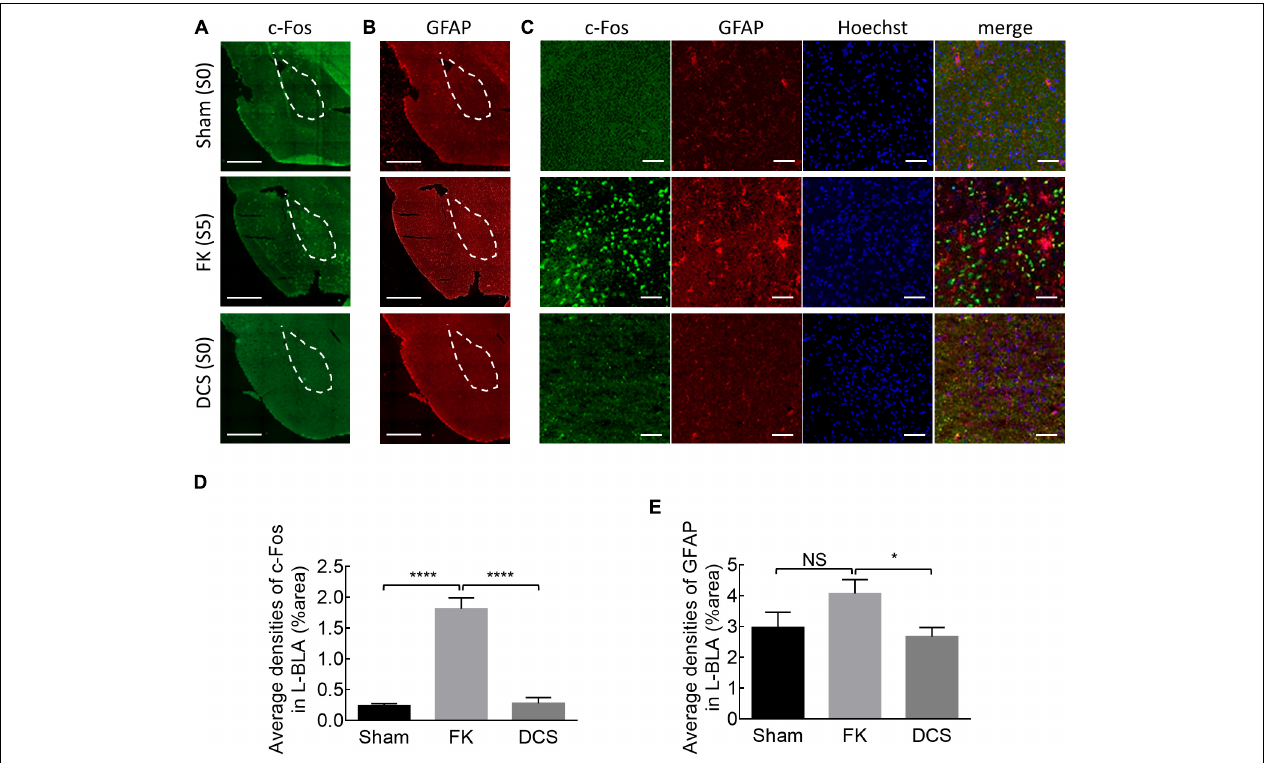
FIGURE 6 | Marked anticonvulsant effect of DCS demonstrated histologically in fully kindled rats. (A) Representative immunostaining images show that cFos expression is markedly increased after the rat was fully kindled (FK, middle panel) when compared to the control rat which acts as normal without kindling (sham, upper panel). The cFos expression was attenuated or even is essentially absent in the left basolateral amygdala (L-BLA) (dotted area) after 40 sessions of 100 µ A, 10 s DCS applied immediately before the challenge stimuli (DCS → Ch) in a fully kindled rat (DCS, lower panel) if compared to the fully kindled rat without DCS (FK). Behaviorally, the rats were in Racine stage 5 and stage 0, 1 h before being sacrificed in the cases without and with DCS, respectively. (B) Reactive gliosis (anti-GFAP) in L-BLA (dotted area) is also markedly increased after fully kindled (FK, middle panel), and reduced with DCS (DCS → Ch, DCS, lower panel) when compared to the fully kindled rat without DCS in the same sections, such as that in Part (A) . Scale bars of (A,B) are 1 mm. (C) The highly magnified and merged images from Part (A, B) with cFos (green), GFAP (red), and Hoechst for cell nuclei (blue) staining in L-BLA, show that cFos and GFAP expression is markedly attenuated after DCS. Scale bars are 0.2 mm. (D,E) cFos-positive cells and GFAP-positive cells in the L-BLA were quantified and statistically analyzed in sham, FK, and DCS groups. n = 10, 22, 16 slices in 3, 4, 4 rats for sham, FK, and DCS groups, respectively. NS p > 0.05; * p < 0.05; **** p < 0.0001, Mann–Whitney U